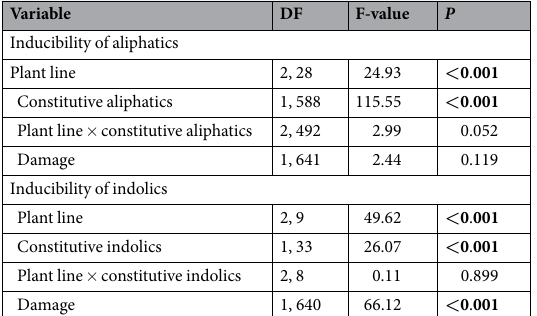
Table 2. Results from general linear mixed models testing for the effects of plant domestication (i.e., plant line) on the inducibility of aliphatic and indolic glucosinolates in leaves. We used three plant lines, the wild cabbage Brassica oleracea ssp. oleracea and two domesticated varieties of this species ( B . oleracea var. acephala and B . oleracea var. capitata). We included constitutive defences in each case to test for a trade-off between constitutive and induced levels for each group of compounds. The interaction term tests for a difference between plant lines in the slope of the relationship between constitutive and inducible defences (i.e., constitutive-induced defence trade- offs). We also included leaf damage score weighted by leaf area as a covariate to account for variation in the amount of damage inflicted on plants from the herbivore-induced treatment. F-values, degrees of freedom (numerator, denominator) and associated significance levels ( P ) are shown. Significant effects ( P < 0.05) are in